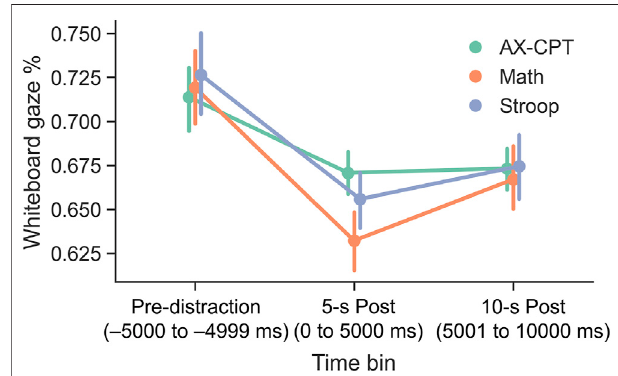
FIGURE3| Average percentage oftime spent lookingat thewhiteboard as a function of 5 s time bins relative to the onset of a distractor objects. The “ pre-distraction ” timebinincludesthe5 sjustpriortothedistractoronset, “ 5-s post ” includesthe fi rst5 safterdistractoronset,andthe “ 10-spost ” time bin includes the 5 – 10 s period after distractor onset. Data demonstrate that the percentage of time the eyes were fi xated on the whiteboard was uniformly high during all three tasks before the onset of a distractor. Looking at the whiteboard decreased signi fi cantly after the distractor onset and this was sustained or up to 10 s after the distractor occurred. The pattern suggests that distractor events reduced looking at the whiteboard that was sustained over time, even when the distractor itself was no longer actively present ( see text).Error bars represent 95% con fi dence intervals after removal ofbetween- subject